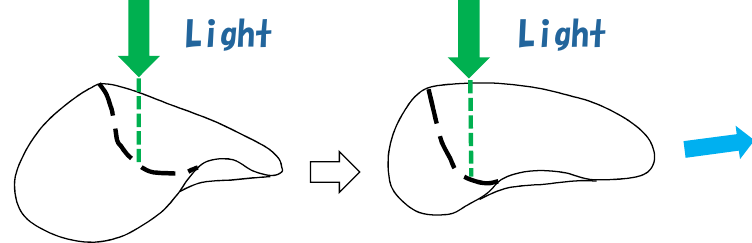
Figure 1. Shape deformation of LCE sample floating on the water under laser light illumination from above [1]. The deformation of the sample edge moves with the movement of the light spot, and at the same time, the LCE sample moves in the opposite direction. The nematic director direction is parallel to the dashed line on the sample